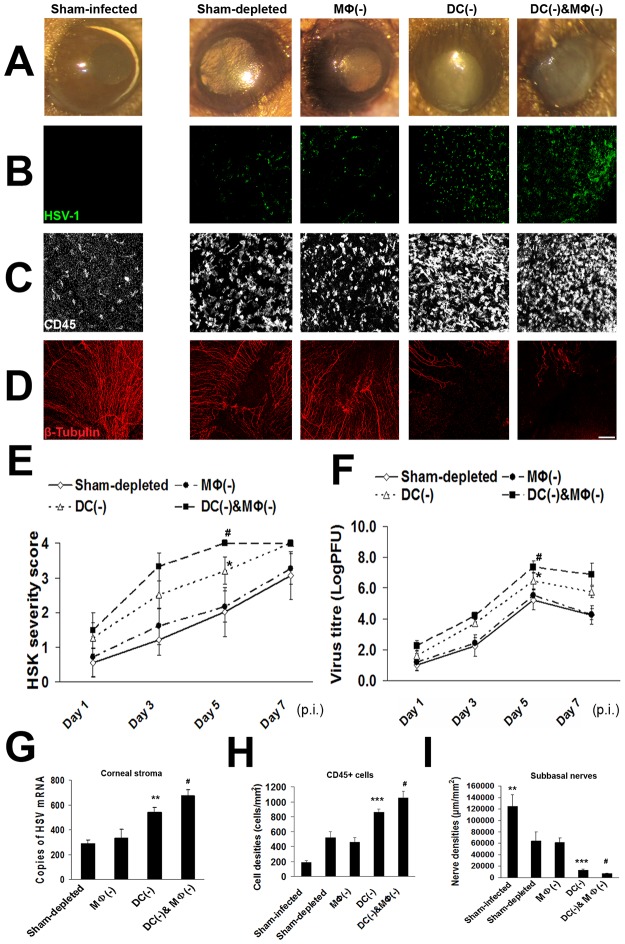
Upon depletion of corneal conventional dendritic cells, virus titers and the local corneal damages are significantly increased in primary herpes simplex keratitis.Infected corneas (n = 5/time point) were collected and virus titers, HSV mRNA levels measurement, or immunohistochemistry studies were performed. cDC and MΦ depletion were compared to sham-depleted infected mice after subconjunctival injections of DT and CL into CD11c-GFP-DTR or C57BL/6 WT mice, as well as to sham-infected mice without active viral inoculation (culture medium alone). Keratitis severity was graded (n = 5/time point). A: Representative corneal photos of primary acute herpes simplex keratitis severity of the mice in different groups are shown. B: Representative micrographs of viral invasion into the corneal stroma of the mice in different groups are shown. C: Representative micrographs of inflammatory cells (CD45+) infiltrating into the corneas of the mice in different groups are shown. D: Representative micrographs of nerve destructions of the mice in different groups are shown. E: The keratitis severity after HSV inoculation in cDC depleted (cDC(-)) mice was significantly increased as compared sham-depleted and MΦ-depleted (MΦ(-)) mice. The keratitis severity with cDC/MΦ double-depletion (cDC(-)&MΦ(-)) was further increased compared to cDC(-) mice. F, G: The viral titer levels (day 5 p.i.) of corneas and HSV-1 mRNA of the corneal stroma were significantly increased in cDC(-) corneas compared to sham controls or MΦ depletion. Double-depletion of cDCs and MΦs showed significantly HSV levels compared to cDC depletion alone. H: Increased inflammatory (CD45+) cells infiltrated corneas with cDC depletion (day 5 p.i.) compared to controls. cDC and MΦ double depletion resulted in increased CD45+ cells compared to cDC depletion alone. I: Corneal nerve density was significantly decreased in cDC depleted or cDC and MΦ double-depleted corneas as compared to sham controls or MΦ depleted corneas. Each experiment was replicated three times. *p<0.05, **p<0.01 and *** p<0.001 compared with sham-depleted; #
p<0.05 compared with cDC depletion (ANOVA with Bonferroni’s post-hoc test, two-sided). Data are shown as mean ± SD. Scale bar: 100 μm.